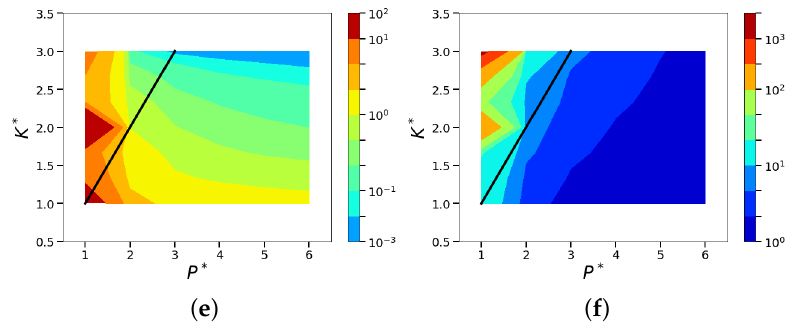
Figure 13. Isocontours of the normalized mean squared ( l 2 ) ELM-based sparse reconstruction error for maximum, minimum, and average error using different choices for the random sensor placement. Left: normalized absolute error metric, (cid:101) 1 . Right: normalized relative error metric, (cid:101) 2 . ( a ) (cid:101) 1 (maximum); ( b ) (cid:101) 2 (maximum); ( c ) (cid:101) 1 (minimum); ( d ) (cid:101) 2 (minimum); ( e ) (cid:101) 1 (average); and ( f ) (cid:101) 2